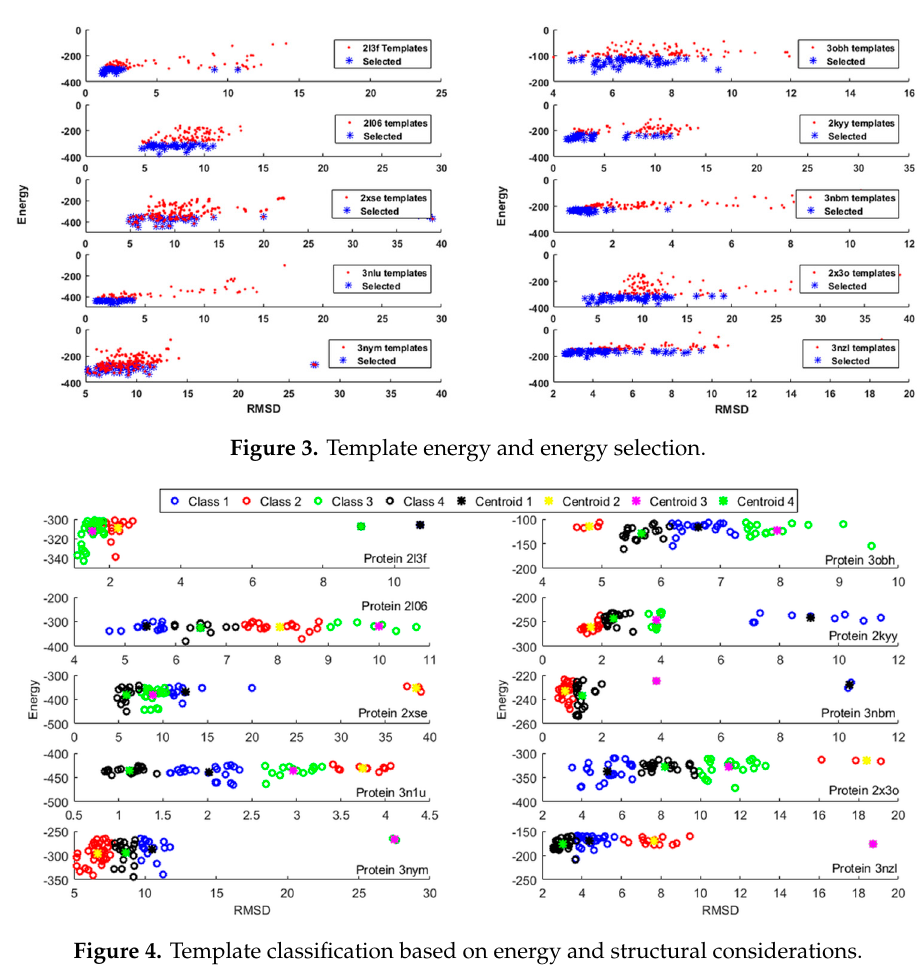
Figure 5. Example of protein classification. Protein 3obh class division and intraclass structural similarity. Figure 6 represents the search space for the first 10 proteins utilized to carry out the PSO sampling (further information about the search space utilized in the rest of the experiments can be